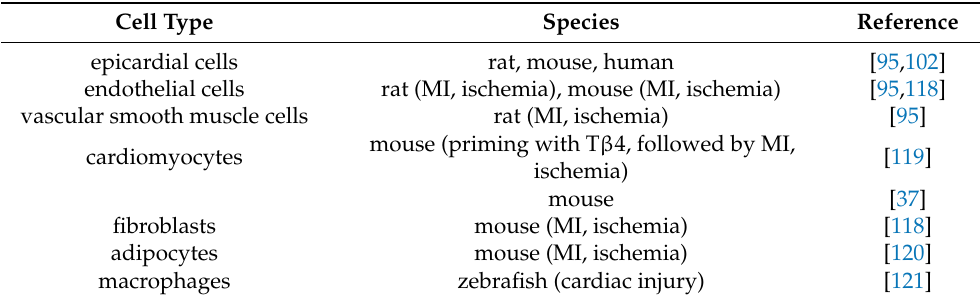
Table 3. Wt1-expressing cell types in adult